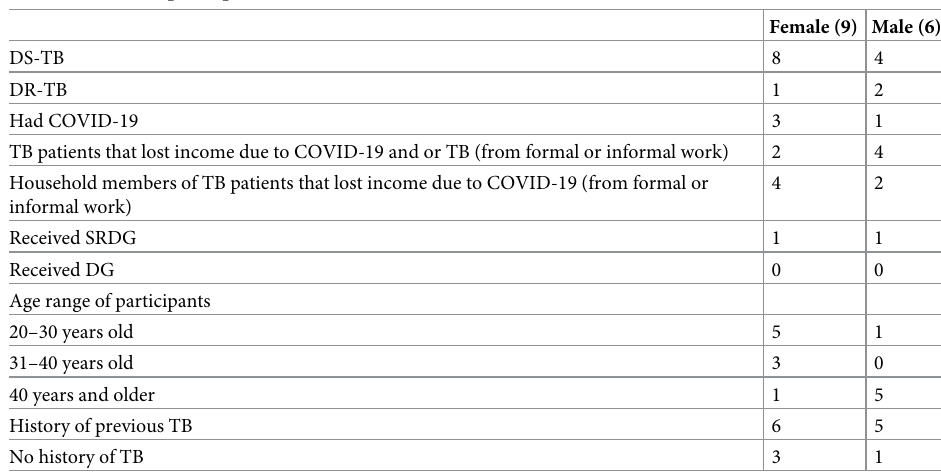
Table 3. Details of